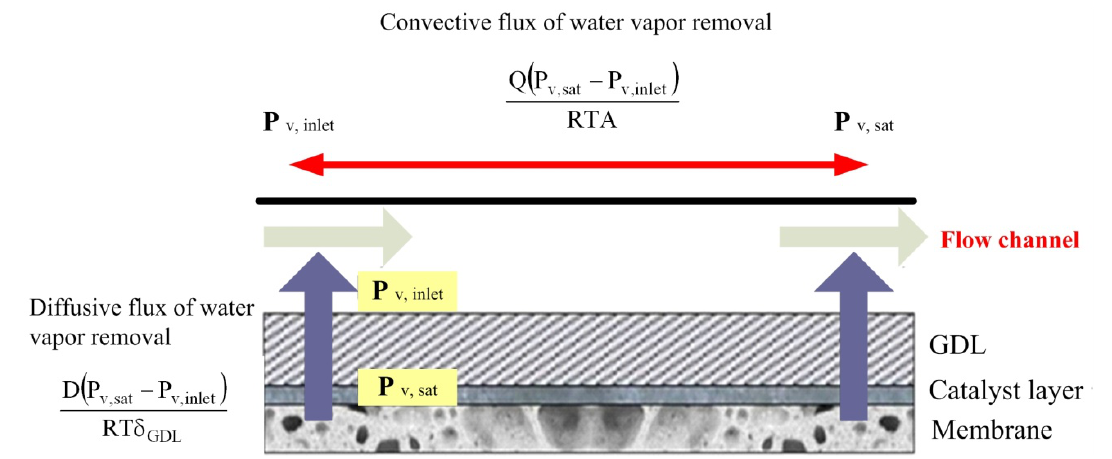
Figure 1. Schematic diagram of water removal during gas purge